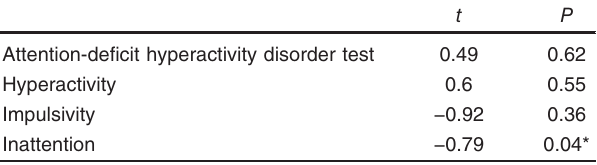
Independent t -test is used. *statistically significant ( P value < 0.05). Table 4 Association between duration of watching television and attention-deficit hyperactivity disorder quotient and subscales of attention-deficit hyperactivity disorder test: hyperactivity, impulsivity, and inattention